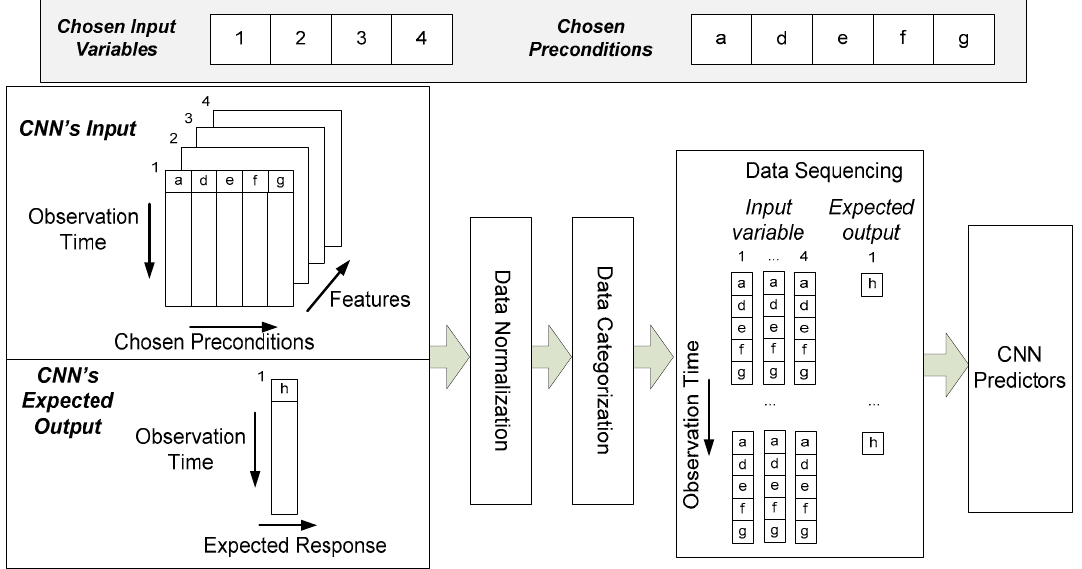
Figure 2. CNN’s predictors and expected output arrangement.